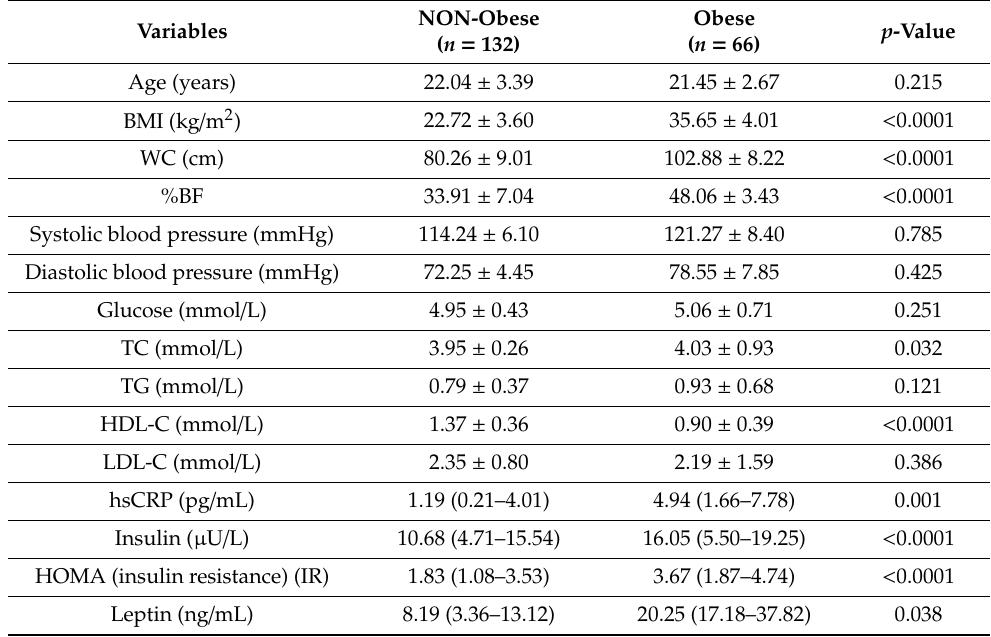
Table 1. The anthropometric measurements and biochemical markers in non-obese subjects compared to obese subjects based on waist